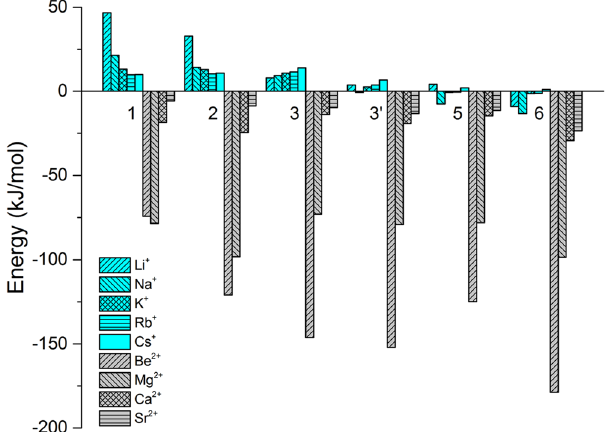
Figure 7. Binding energy differences ( Δ BE) of SO 2 to selected NHCs in the presence of monovalent (bright blue) and divalent cations